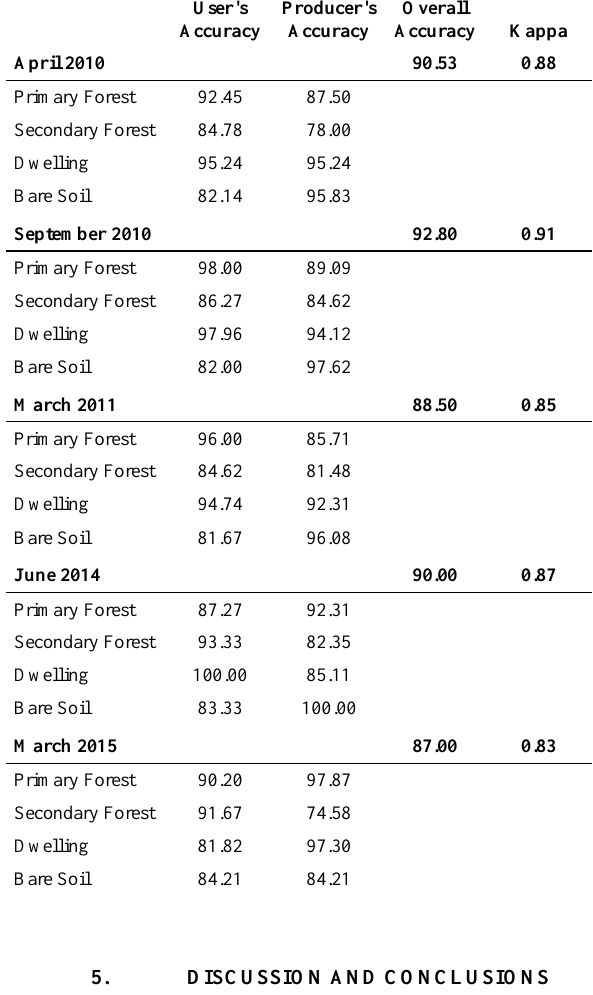
Table 2 . Accuracy assessment of land cover